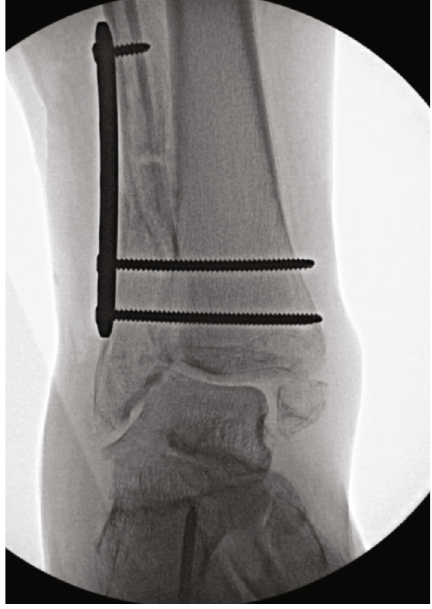
Figure 3: Partial correction of valgus deformity with plate-assisted talar